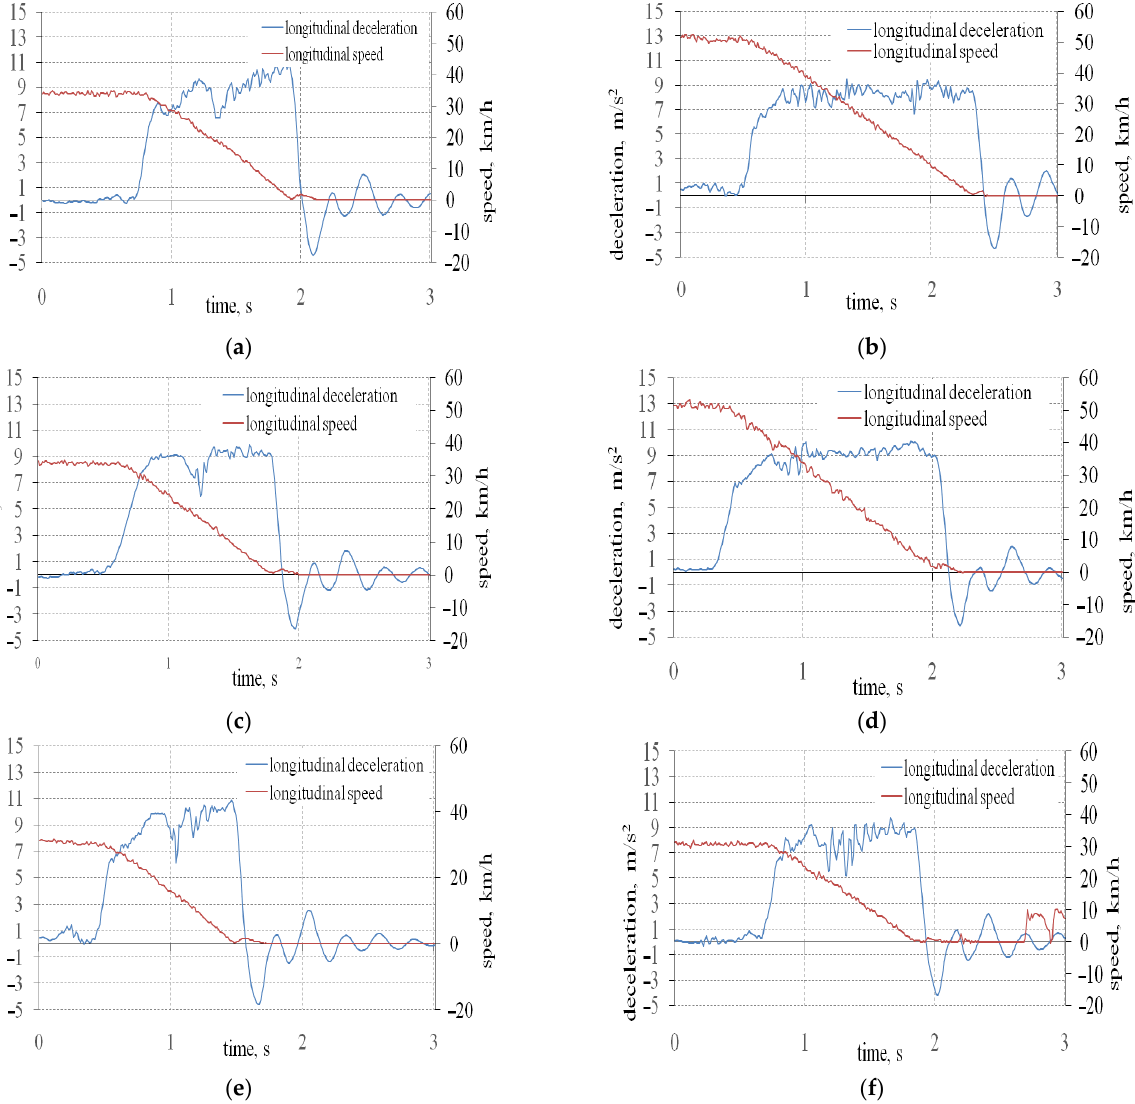
Figure 4. Examples of the presentation of values of longitudinal deceleration and longitudinal speed over time registered for a category N1 vehicle during braking tests carried out on: ( a ) dry asphalt pavement from 30 km/h, ( b ) dry asphalt pavement from 50 km/h, ( c ) wet asphalt pavement from 30 km/h, ( d ) wet asphalt pavement from 50 km/h, ( e ) dry concrete pavement from 30 km/h, ( f ) wet concrete pavement from 30 km/h.